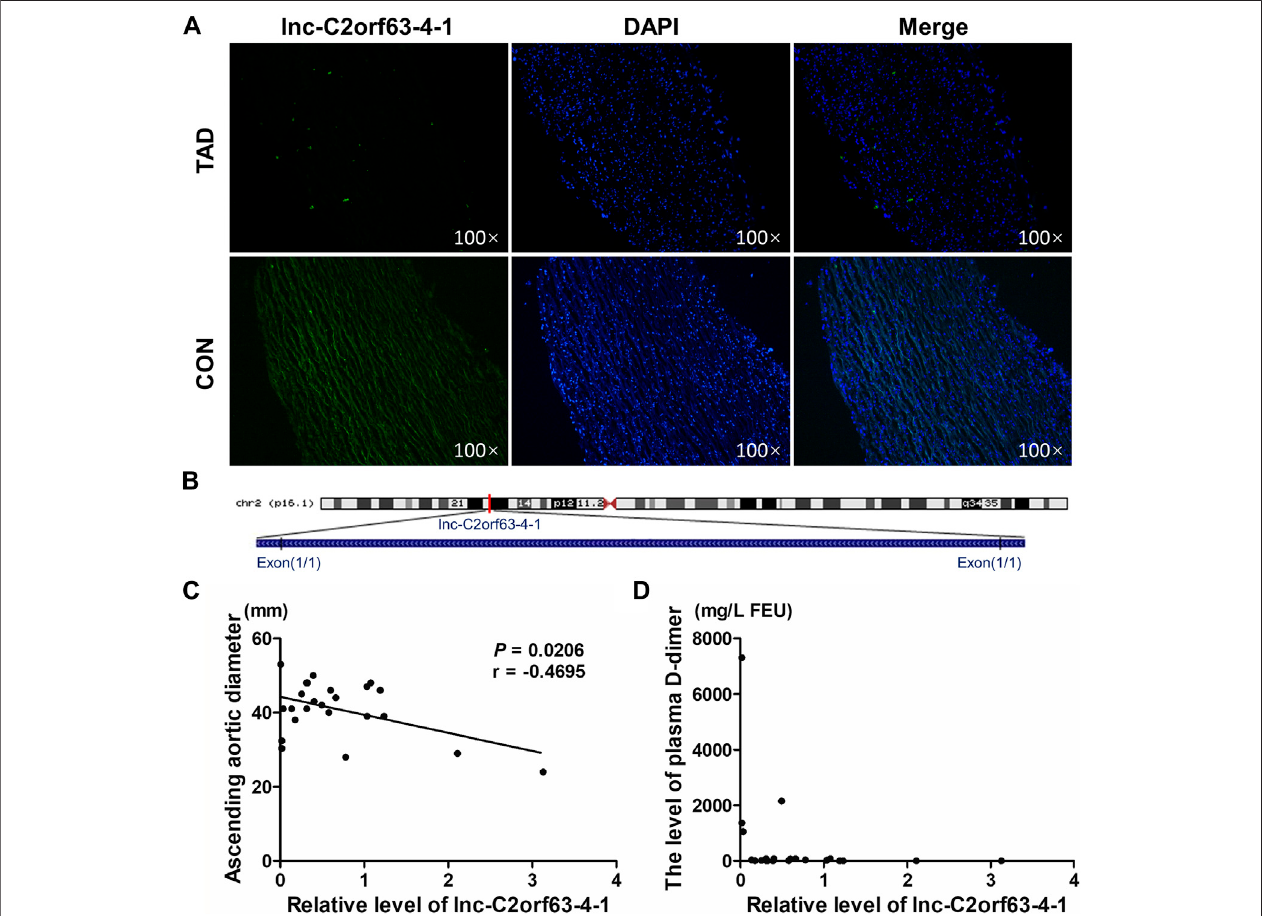
FIGURE 2 | The reduced expression of lnc-C2orf63-4-1 is associated with the aortic arch width in clinical TAD patients. (A) RNA-FISH for lnc-C2orf63-4-1 in isolated aorta tissues in TAD patients and healthy controls, clearly suggesting that lnc-C2orf63-4-1 was down-regulated in TAD ( n (cid:1) 3/per group). (B) Schematic annotation of lnc-C2orf63-4-1 genomic locus on chromosome 2q54.972.558-54.972.776 in humans. The length is 218nt. (C) The correlations between the lnc- C2orf63-4-1 expression and ascending aorta diameter of TAD were shown by Pearson ’ s correlation coef fi cient ( n (cid:1) 15 in the control group, n (cid:1) 24 in the TAD group). (D) The correlations between the lnc-C2orf63-4-1 expression and serum D-dimer levels of TAD were shown by Pearson ’ s correlation coef fi cient ( n (cid:1) 15 in the control group, n (cid:1) 24 in the TAD group).